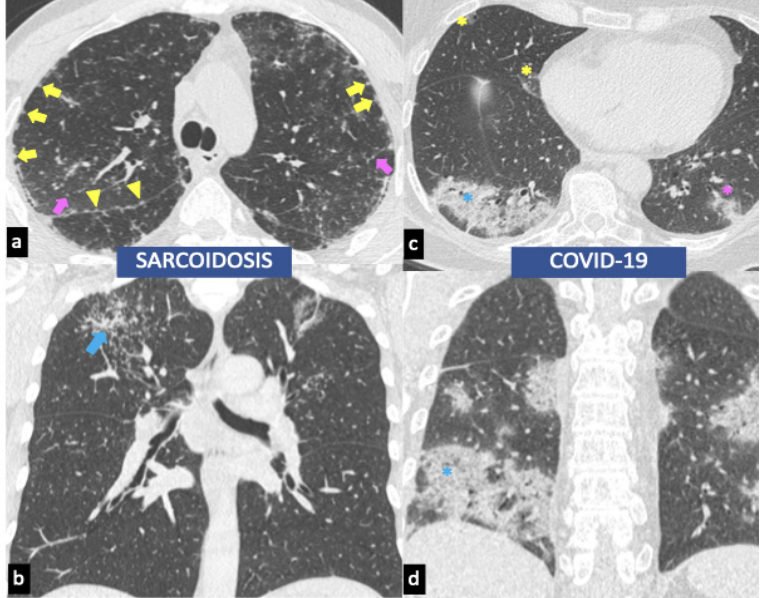
Figure 3. HRCT findings of sarcoidosis vs. COVID-19. Sarcoid-related micronodules corresponding to granulomas have a perilymphatic distribution and are located along scissural (yellow arrowheads), subpleural interstitial space (yellow arrows), and interlobular septa (pink arrows) in a symmetric and upper lobe distribution ( a ). Galaxy sign is an atypical finding of sarcoidosis (blue arrow, b ). Peripheral ground-glass opacities (early stage; 0–5 days after symptom onset) are instead frequent HRCT manifestations of COVID-19 in the pre-vaccination era (yellow asterisks, c ), with or without lung consolidation (peak stage; 9–13 days after symptom onset, pink asterisks, c ). A crazy-paving pattern has an intermediate incidence (blue asterisks, c , d ).